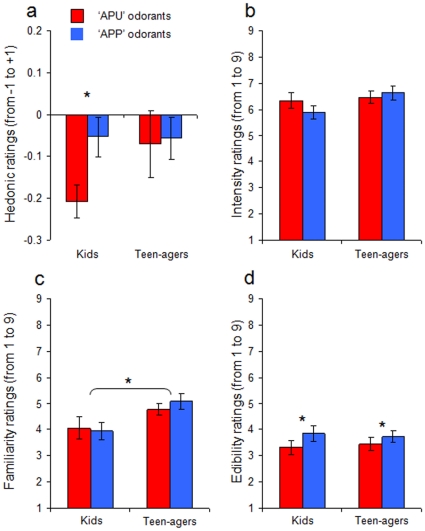
Experiment 2.a) Hedonic ratings for APU and APP odorants in kids and teen-agers: Kids (but not teen-agers) judged APP odorants more pleasant than APU odorants. b) Intensity ratings for APU and APP odorants in kids and teen-agers: No difference in intensity ratings was observed between odorant types and between age groups. c) Familiarity ratings for APU and APP odorants in kids and teen-agers: No difference in familiarity ratings was observed between odorant types; however, teen-agers rated odorants as more familiar than kids. d) Edibility ratings for APU and APP odorants in kids and teen-agers: APP odorants were rated as more edible than APU odorants. * significant difference at the 5% statistical significance threshold.